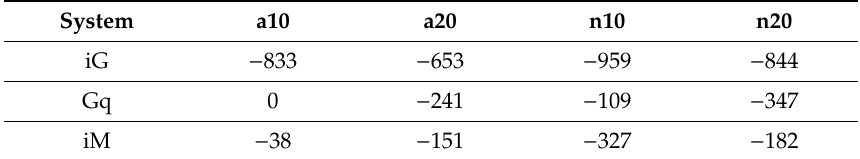
Table 1. Interaction energy between fCNT and the whole iG, its Gq part, and iM part determined from the very last 4 ns of simulations. The energy is expressed in kJ mol − 1 . System